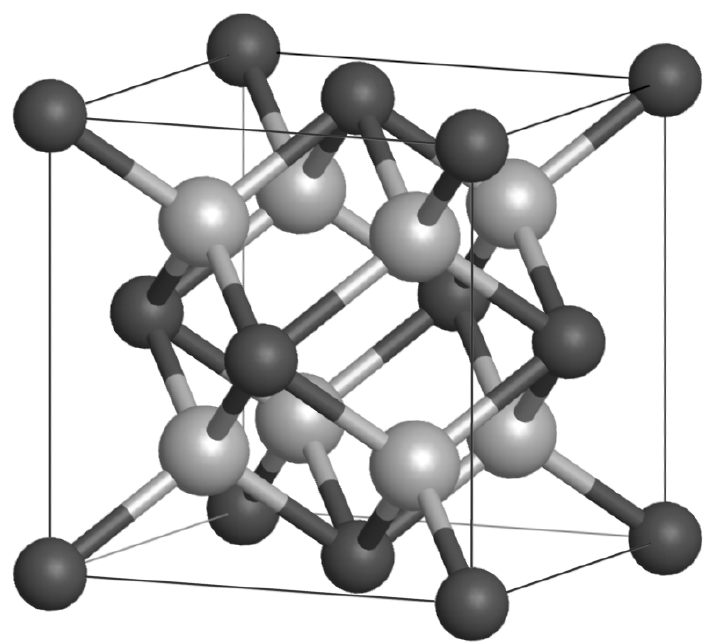
Figure 1. Fluorite-type crystal structure of CeO 2 (Ce atoms are in dark grey and O atoms are in light grey).